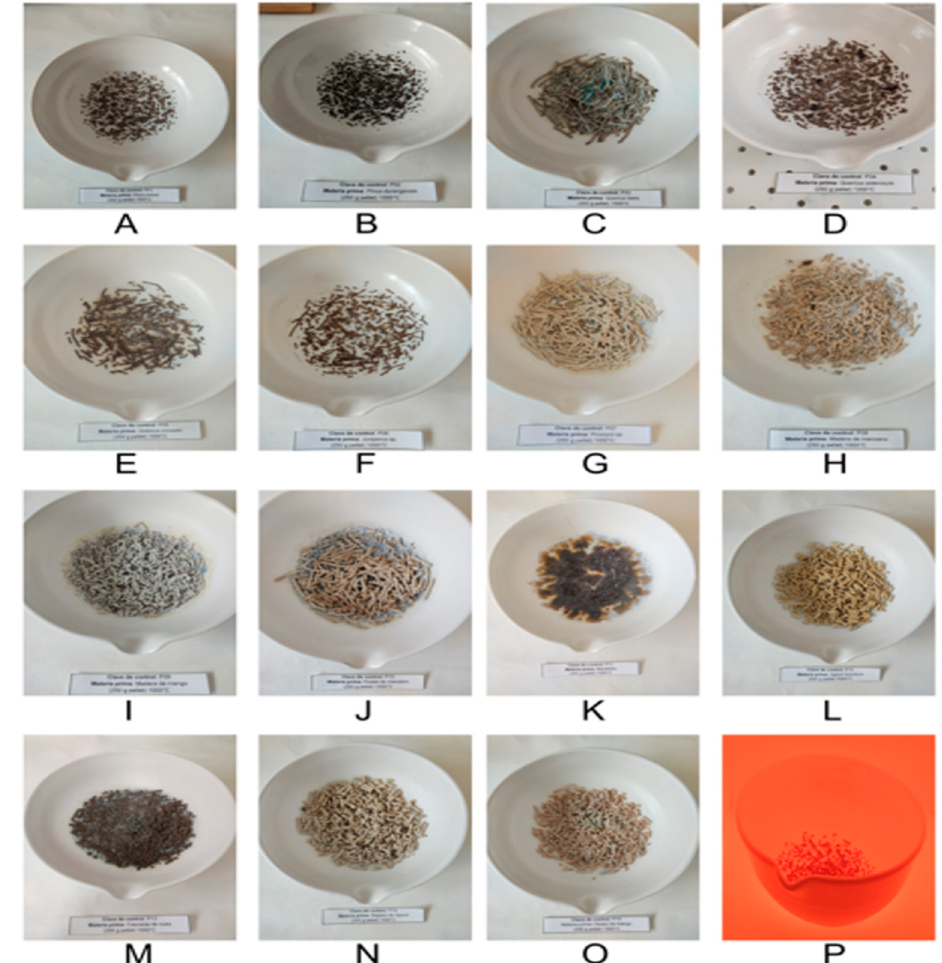
Figure 1. Sintered ash and slag formation from 15 pellet sources subjected to calcination at 1000 °C using the BioSlag test: horizontally ( A – G ) pellets from forest sources; ( H – K ) pellets from agricultural sources; ( L – O ) pellets from agro-industrial sources; ( P ) sintering process at 1000 °C. Table 3. Level of sintering of biofuels using the BioSlag Test.